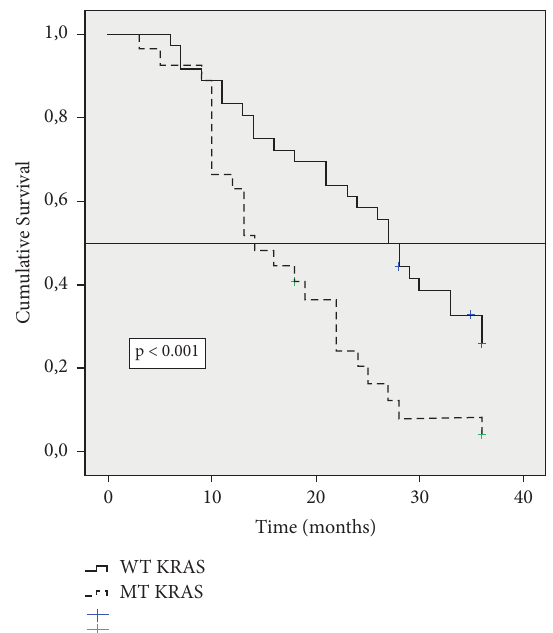
Figure 3: Kaplan–Meier survival function curve in patients with PCI 11–20 according to KRAS mutation status. The horizontal bar denotes median survival.